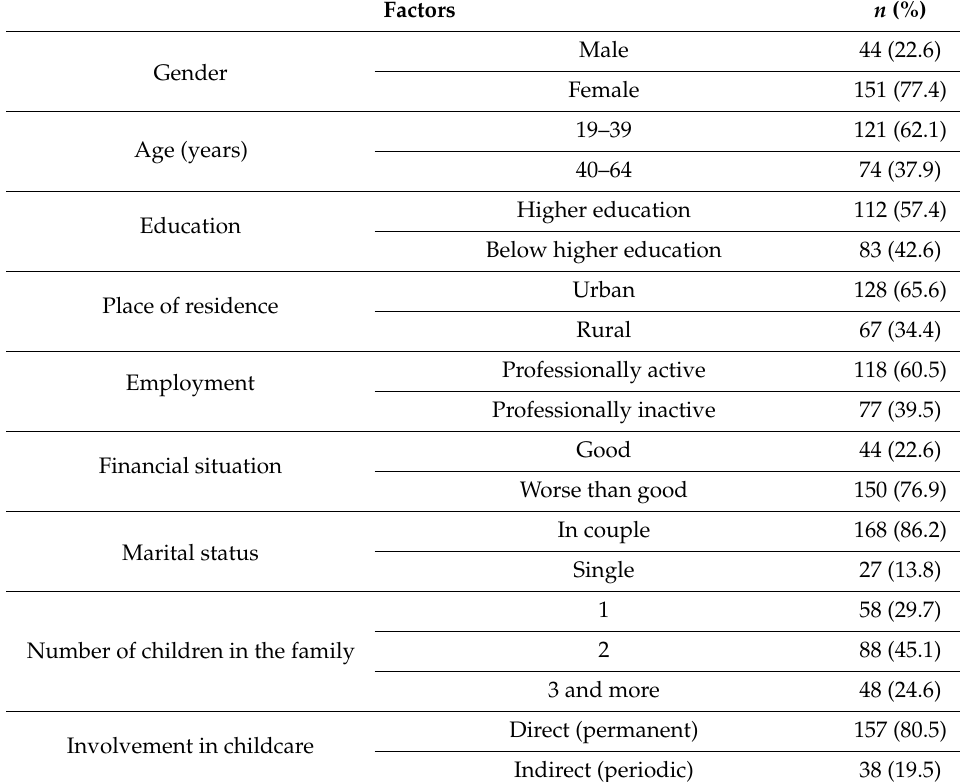
Table 1. Respondent data by sociodemographic and medical factors ( n =